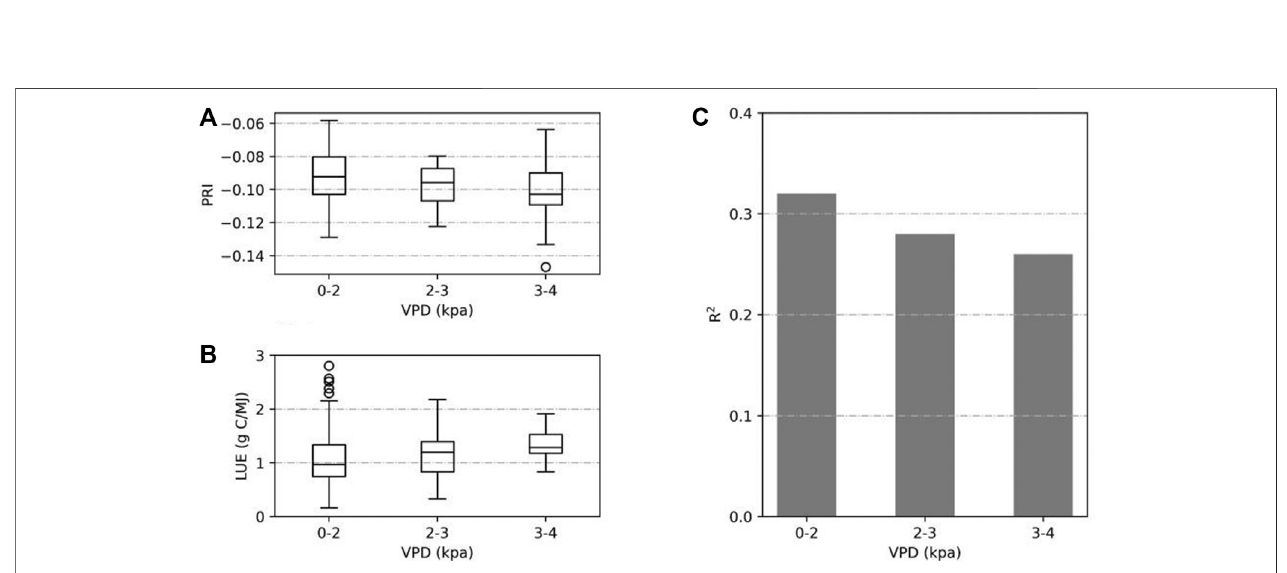
FIGURE 9 | Half-hour time scale of PRI and LUE are as affected by VPD (A , B) . Correlation between PRI and LUE under different VPD gradings (C) .